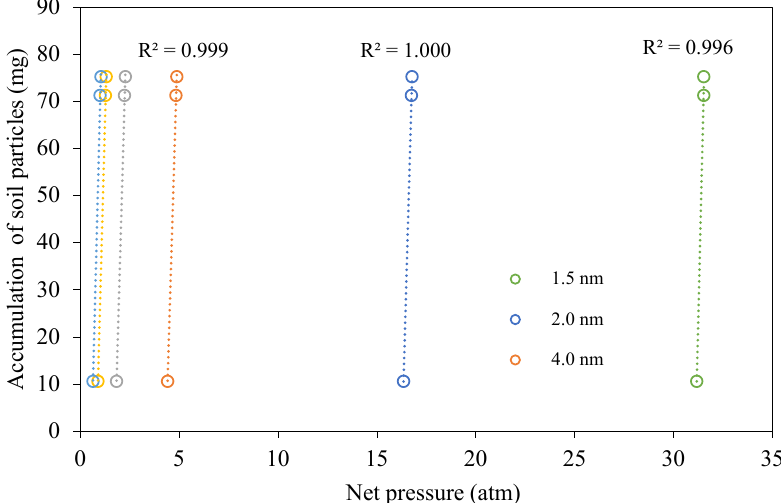
Figure 3. Distributions of electrostatic repulsive pressure( a ); hydration repulsive pressure, van der Waals attractive pressure, and its resultant pressure ( b ); net interaction pressure ( c ).